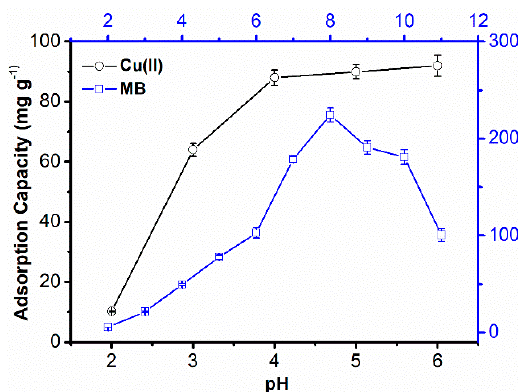
Figure 8. Effect of pH value on the adsorption capacity of MB and Cu(II).